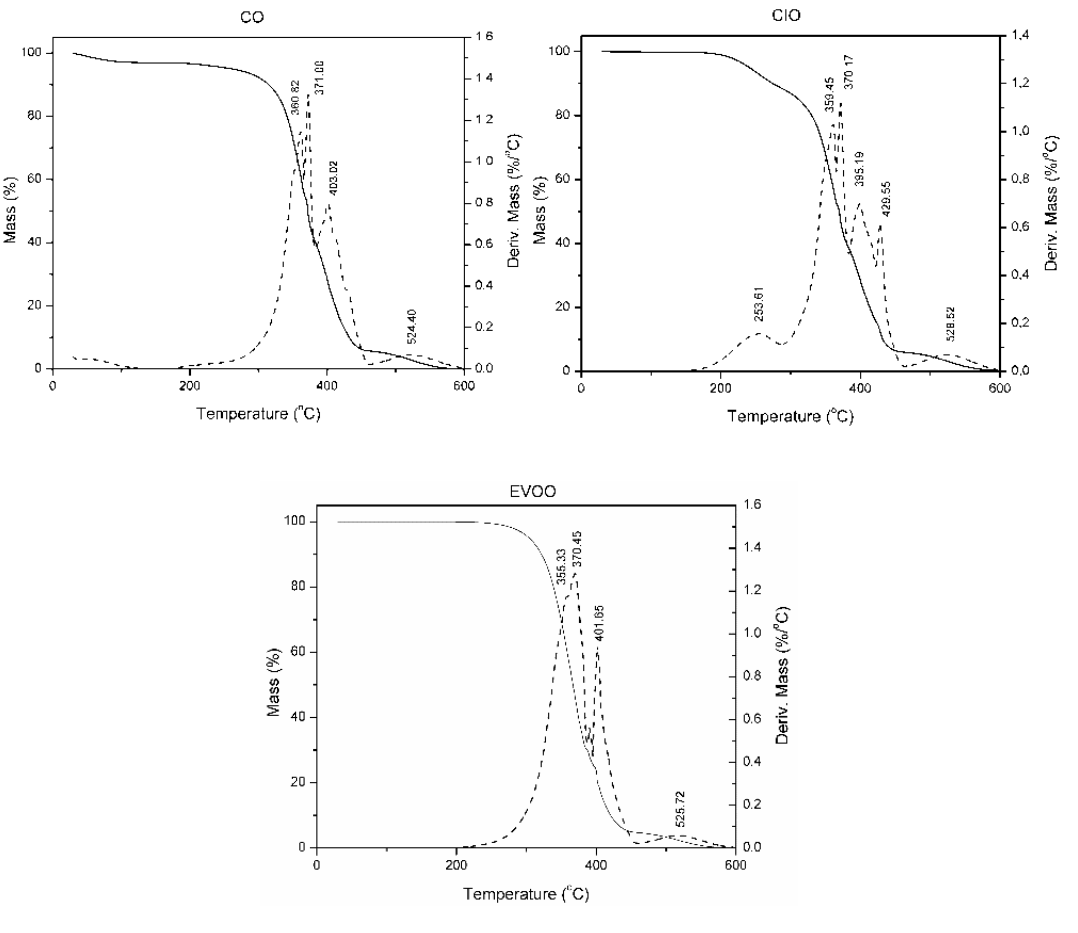
Figure 2. Mass Loss-Derivate (TG / DTG) thermograms of Colliguaya integerrima (CIO), Cynara cardunculus Figure 2. Mass Loss–Derivate (TG/DTG) thermograms of Colliguaya integerrima (CIO), Cynara (CO), and extra-virgin olive (EVOO) cardunculus (CO), and extra-virgin olive (EVOO) oils.